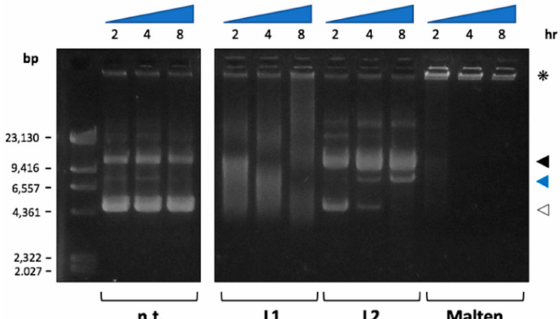
Figure 9. DNA electrophoretic mobility assay. Effects of L1 and L2 (malten as control) on the migration of pLL3.7 plasmid DNA. Complex structural alterations ( ❋ ), supercoiled DNA (white arrow), open circular DNA (black arrow) and linearized DNA (blue arrow). N.t.—not